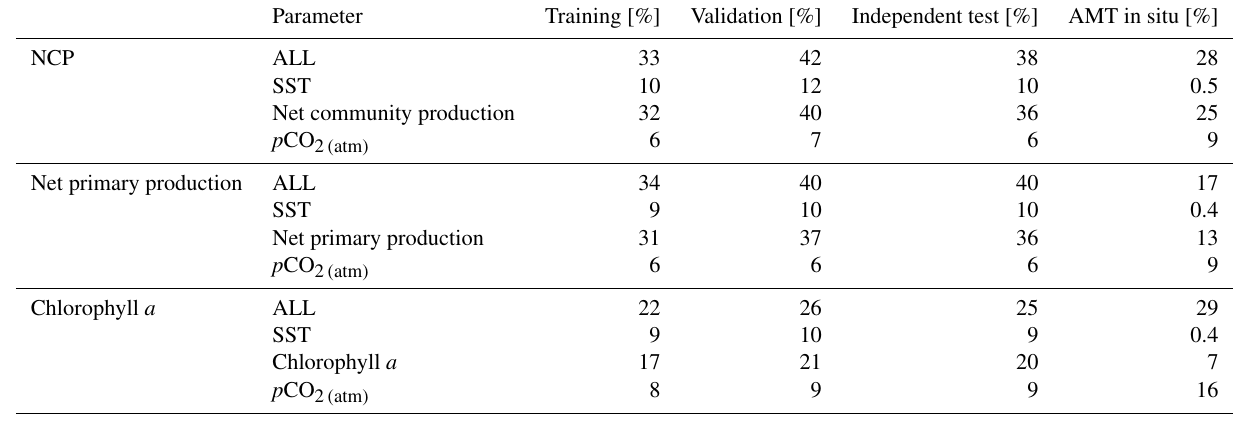
Table A1. The percentage reduction in root mean square difference (RMSD) attributable to the uncertainties in the input parameter for each training and validation data set determined from a perturbation analysis as described in Sect. 2.5.